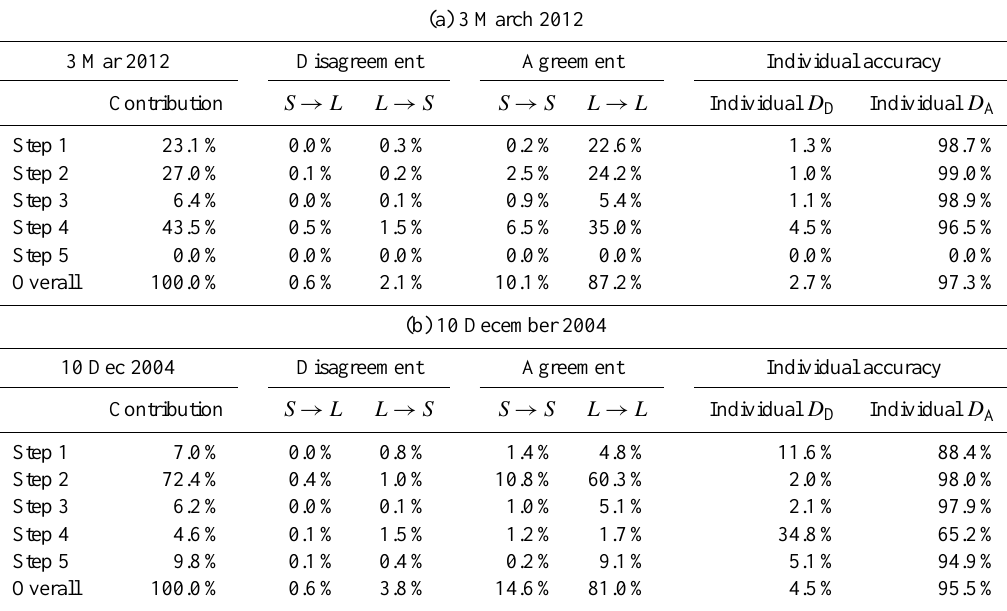
Table 9. Results of the validation step by step for 3 March 2012 and 10 December